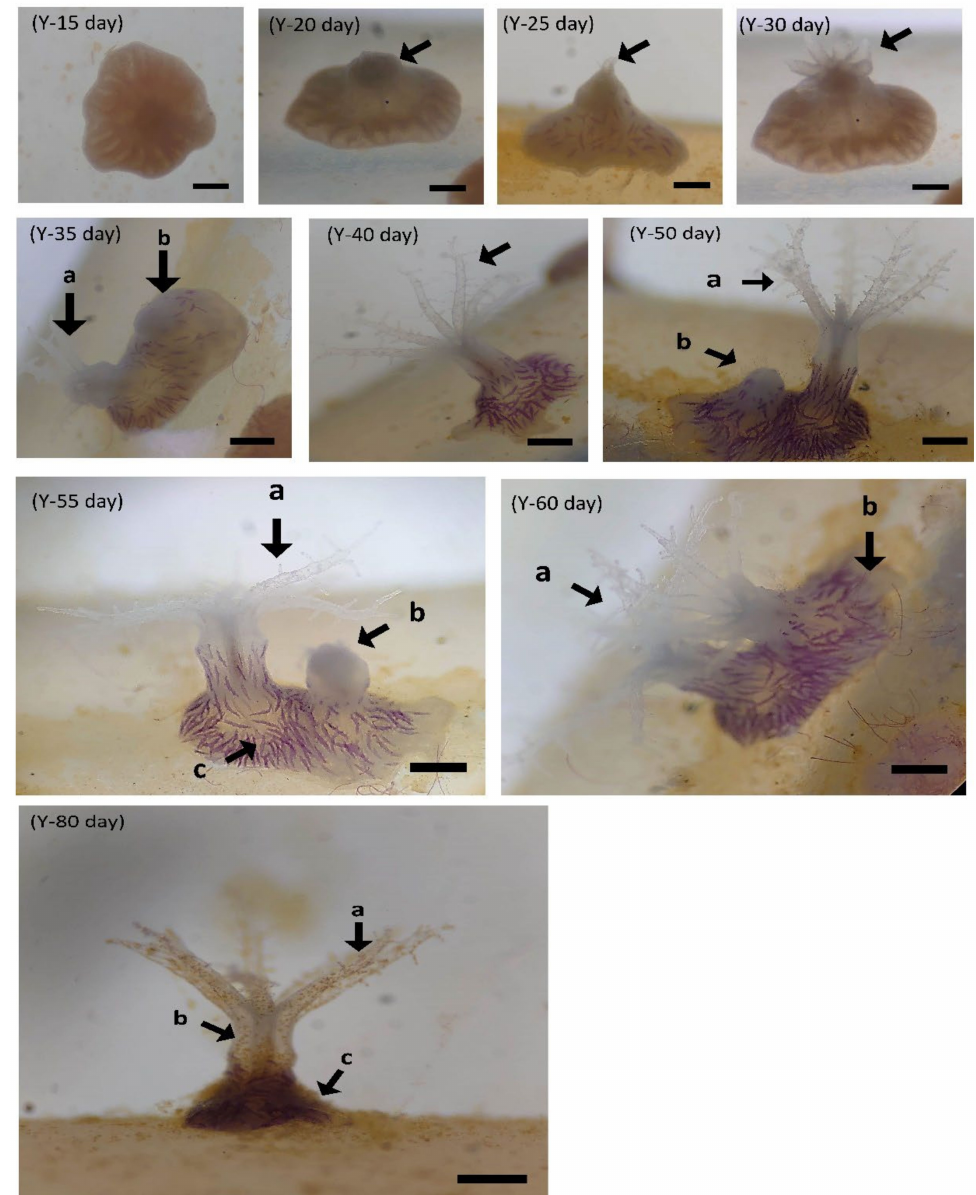
Figure 8. The effect of feeding on Briareum violacea juvenile development during temperature and salinity stress. Y, feeding treatment group (scale bar: 100 µ m). Fifteen days: in the Y group, the polyps’ organization begins to expand. Twenty days: in the Y group, the middle is raised; the arrow points to the undifferentiated polyps. Twenty-five days: in the Y group, a tentacle appears in the middle bulge. Thirty days: in the Y group, it can be observed that the development of the polyp is completed (the arrow points to it). Thirty-five days: in the Y group, coenosarc begins to expand and grow outward (indicated by the arrows; a, original polyp; b, coenosarc tissue). Forty days: in the Y group, polyps are about 300 µ m long and spicules can already be observed in polyps. Fifty days: in the Y group, polyps begin schizogamy (indicated by the arrows; a, original polyp; b, new schizogamy polyp). Fifty-five days: in the Y group, raised tissue forms next to the polyps (indicated by the arrows; a, original polyp; b, new schizogamy polyp; c, coenosarc tissue). Sixty days: in the Y group, polyps split into two polyps (indicated by the arrows; a, original polyp; b, new schizogamy polyp). Eighty days: in the Y group, there are many golden yellow zooxanthellae in the polyps’ tissue (indicated by the arrows; a, tentacles containing zooxanthellae; b, polyp; c, coenosarc